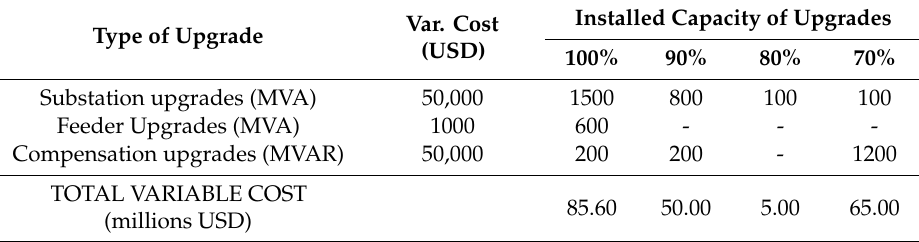
Table 13. Variable cost of the planning solutions for each scenario proposed.